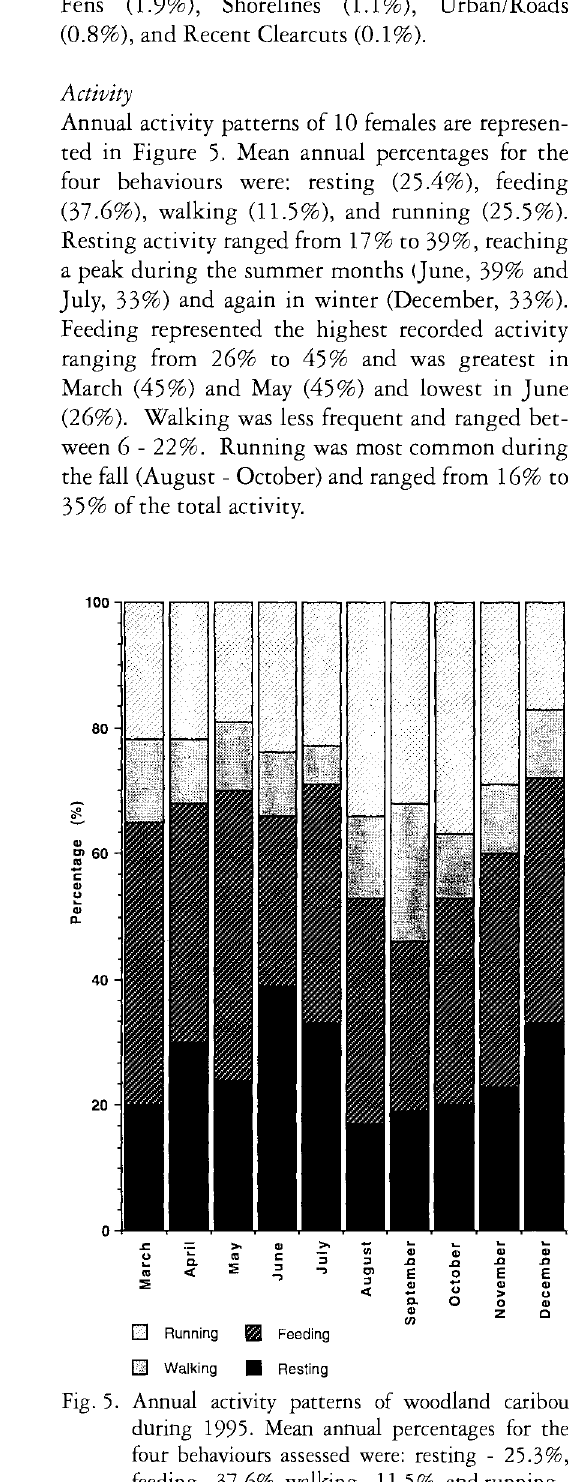
Fig. 5. Annual activity patterns of woodland caribou during 1995. Mean annual percentages for the four behaviours assessed were: resting - 25.3%, feeding - 37.6%, walking - 11.5%, and running -